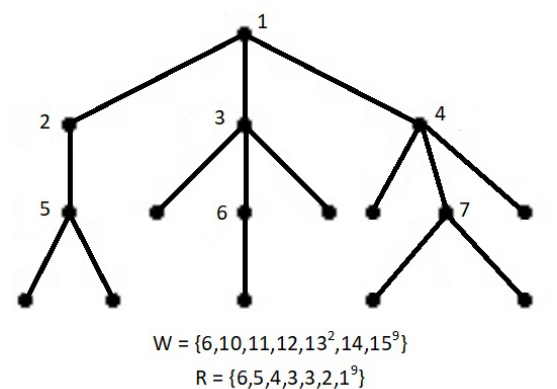
Figure 6. T 1 = (4,5,6), T 2 = (3), T 3 = (2,1,1), T 4 = (1,1,3), T 5 = (1,1), T 6 = (1), T 7 =